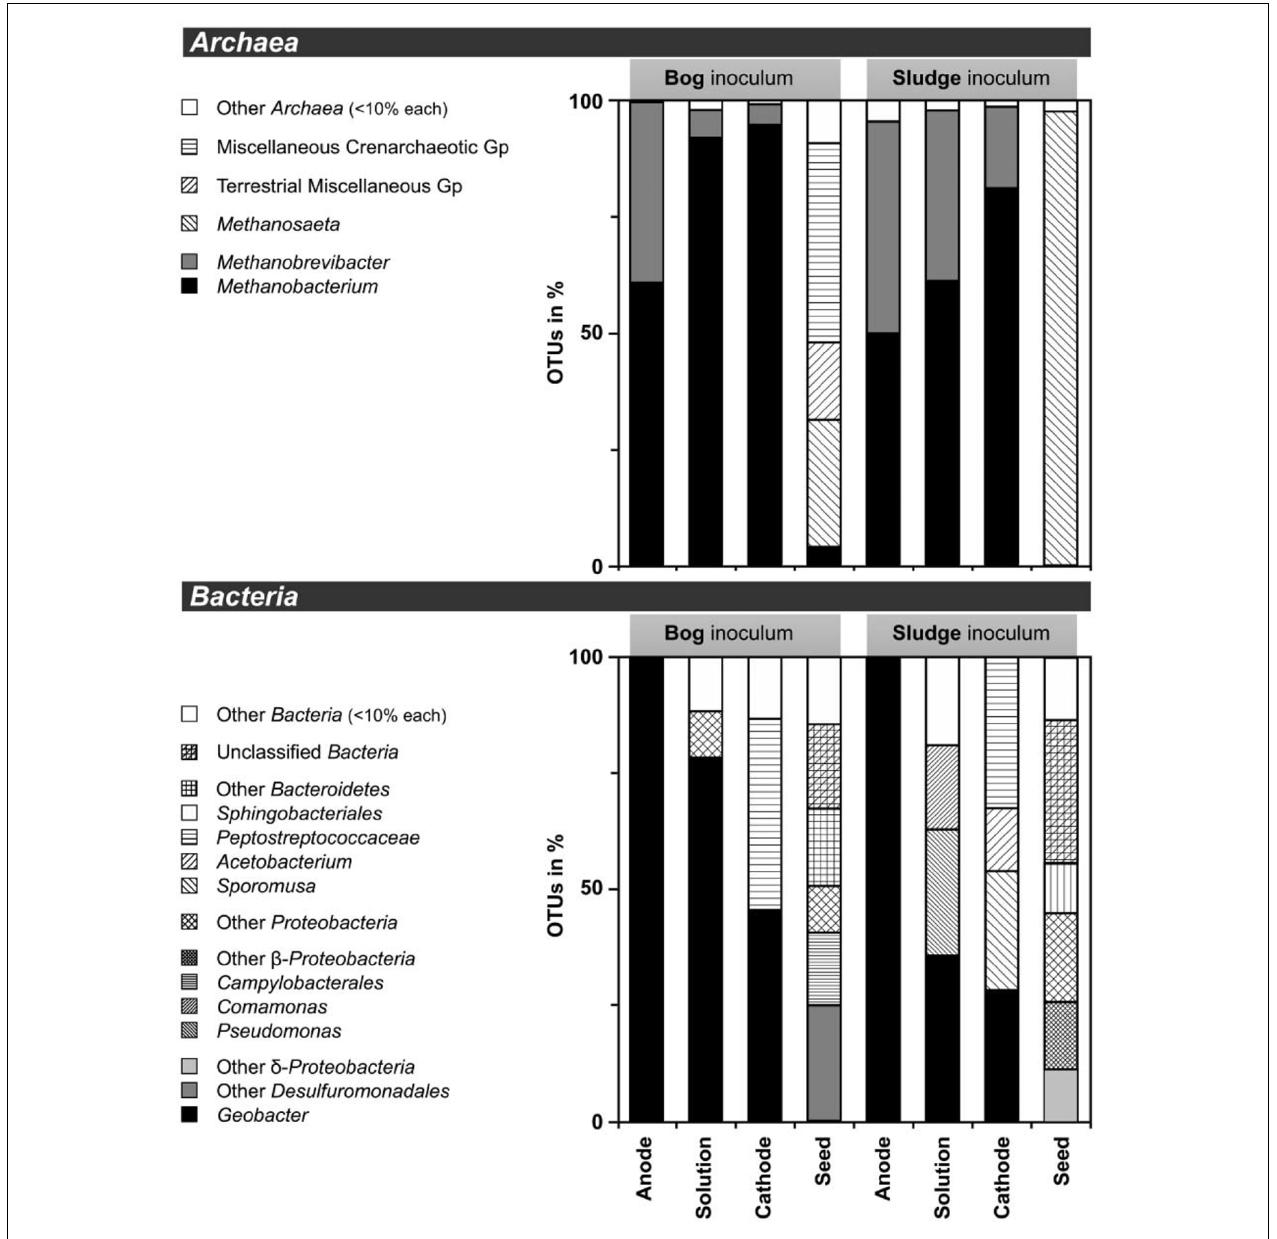
FIGURE 5 | Distribution of operational taxonomic units (OTUs) of less than 97% sequence similarity in 16S rRNA gene extracted from MEC reactors. DNA extracts of 0.01, 0.1, 1, 10, and 25% were pooled prior to